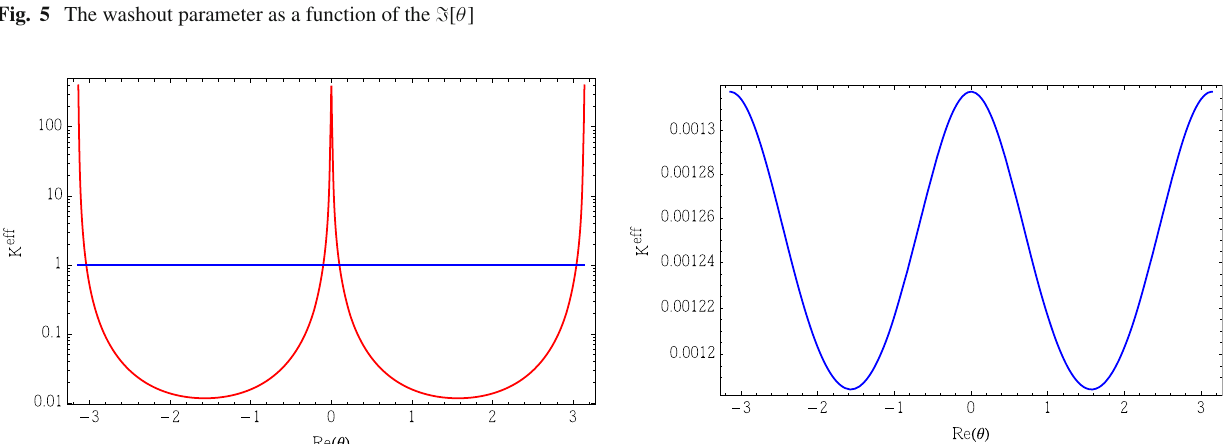
Fig. 5 The washout parameter as a function of the (cid:11)[ θ ]